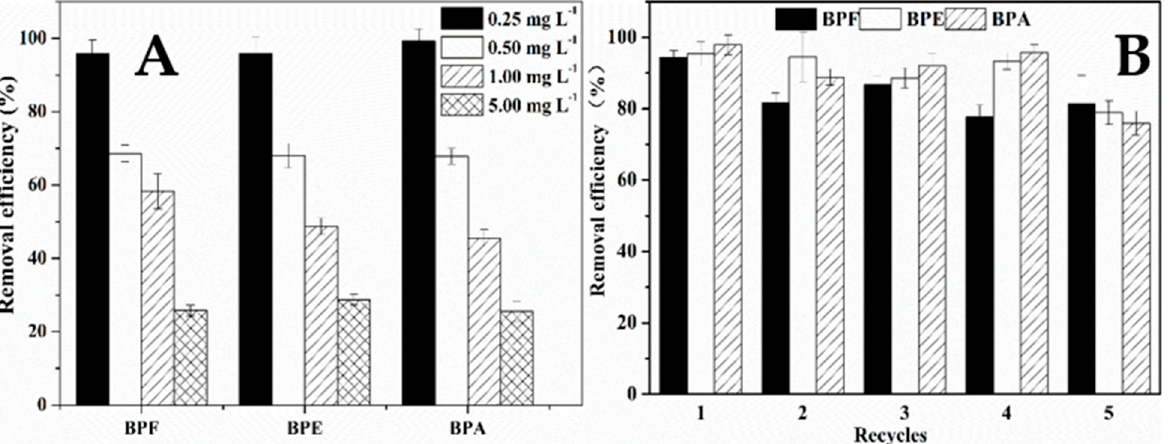
Figure 6. ( A ) Removal efficiency of m-DMI-MSNPs and m-NI-MSNPs towards BPs, and ( B ) the re-